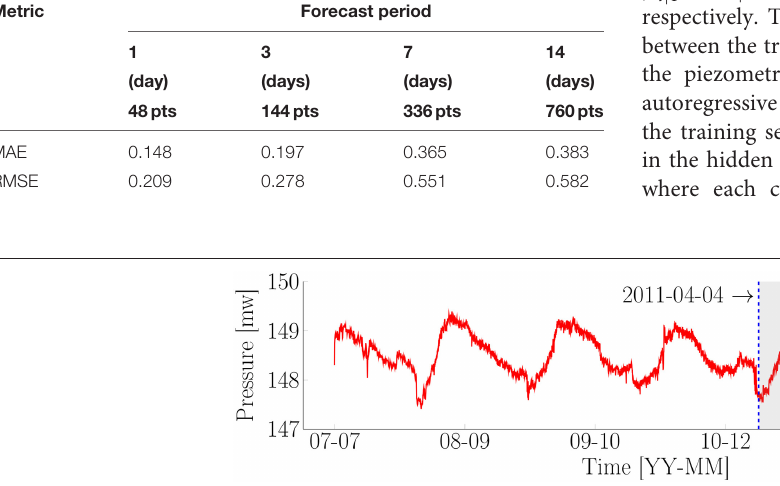
TABLE 1 | Evaluation of forecast accuracy with respect to the different forecast periods for the traffic load data. Metric Forecast period